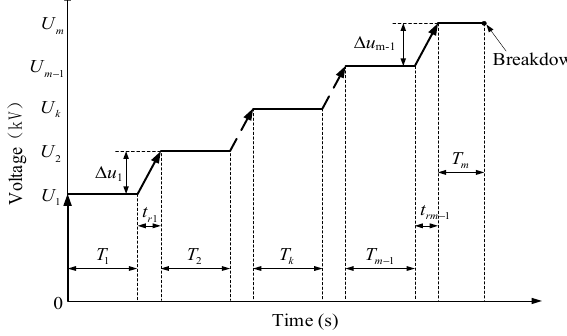
Figure 1. The voltage protocol for step-stress tests.